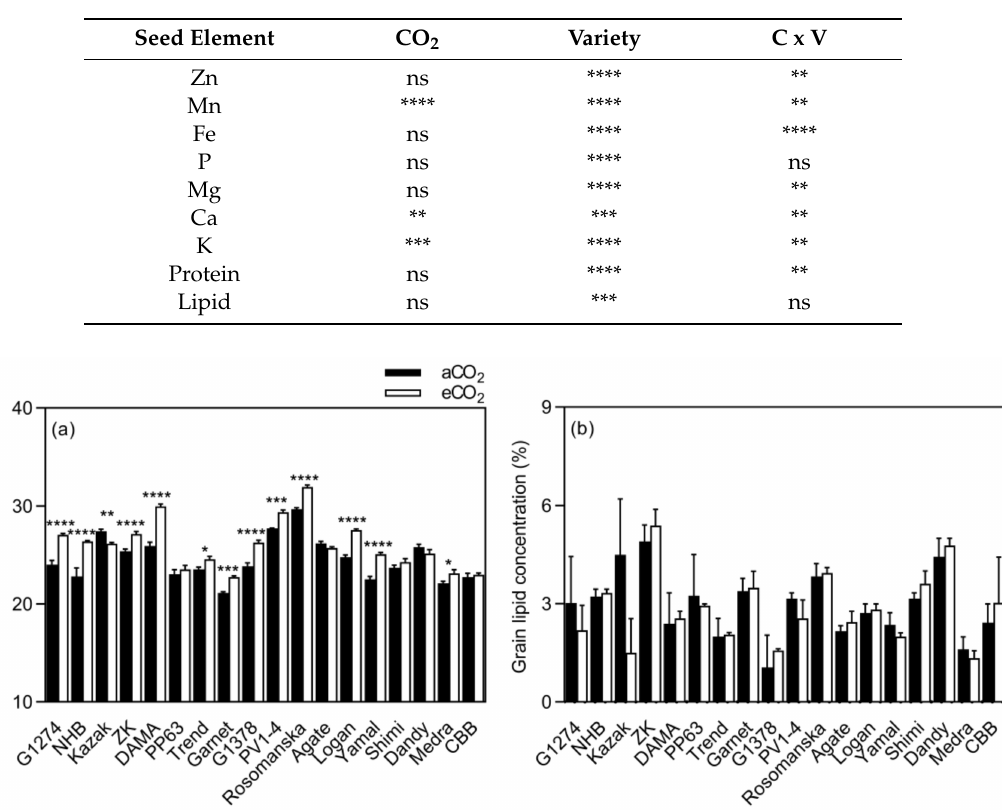
Table 4. Significance levels of main e ff ects and interactions of CO 2 and varieties on soybean grain nutrient, protein, and lipid concentrations at maturity. ns, not significant; ** p < 0.01; *** p < 0.001; **** p < 0.0001.